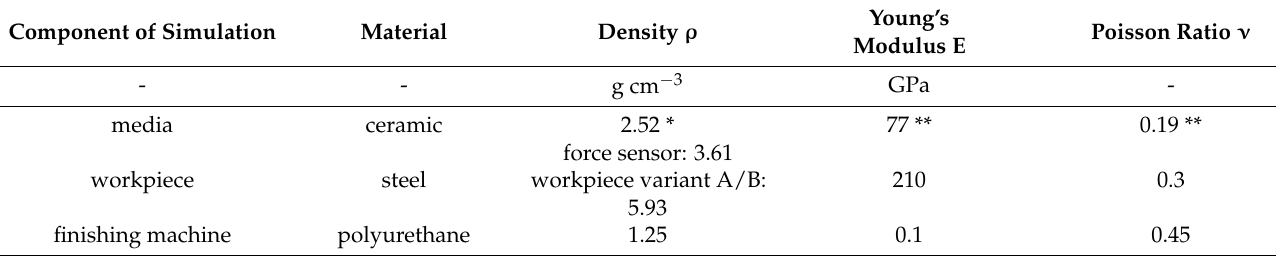
Table 1. Material parameters of the simulation components.